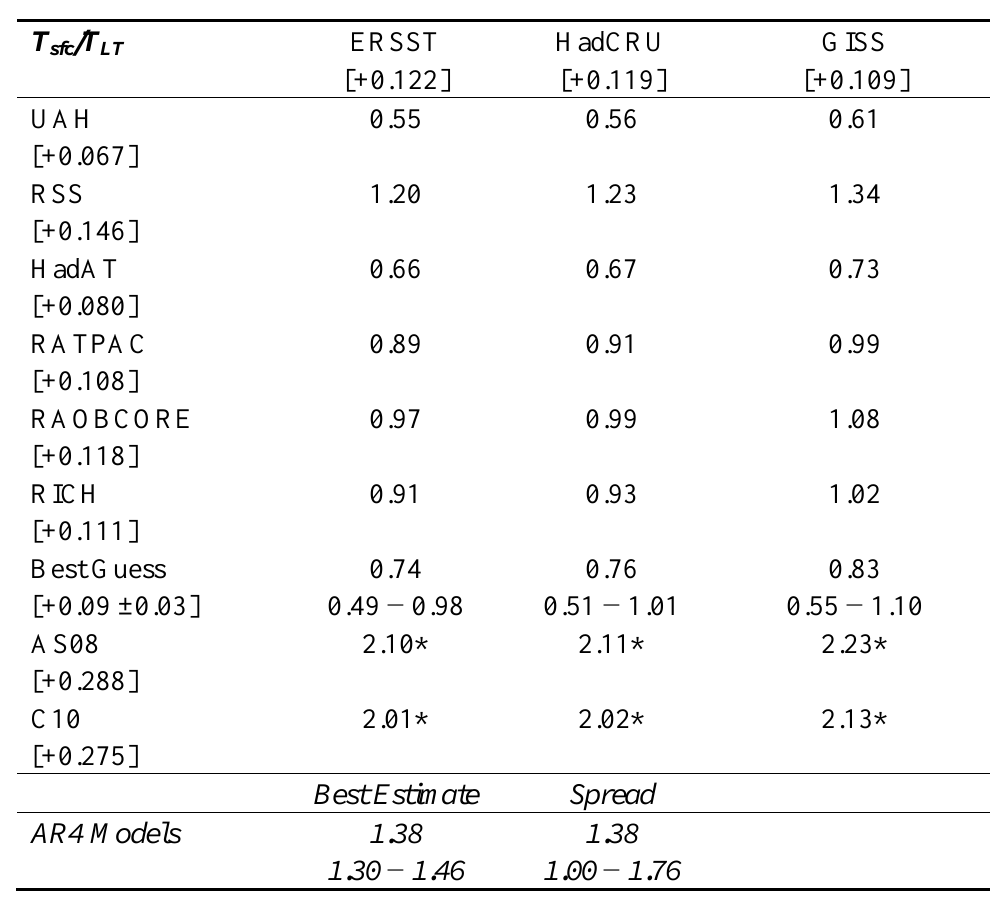
Table 2. Scaling ratios of T /T . The T trend value used as the denominator is identified LT sfc sfc by column except in the last row where the AR4 Model SR s are computed from each models’ own unique trends and are italicized to highlight this aspect. The ―best estimate‖ is calculated from 21 AR4 model realizations and S is the ―spread‖. Both AS08 and C10 are relative to 1979–2005 trends for T *. Actual trends are given in brackets associated with sfc each dataset (°C decade −1